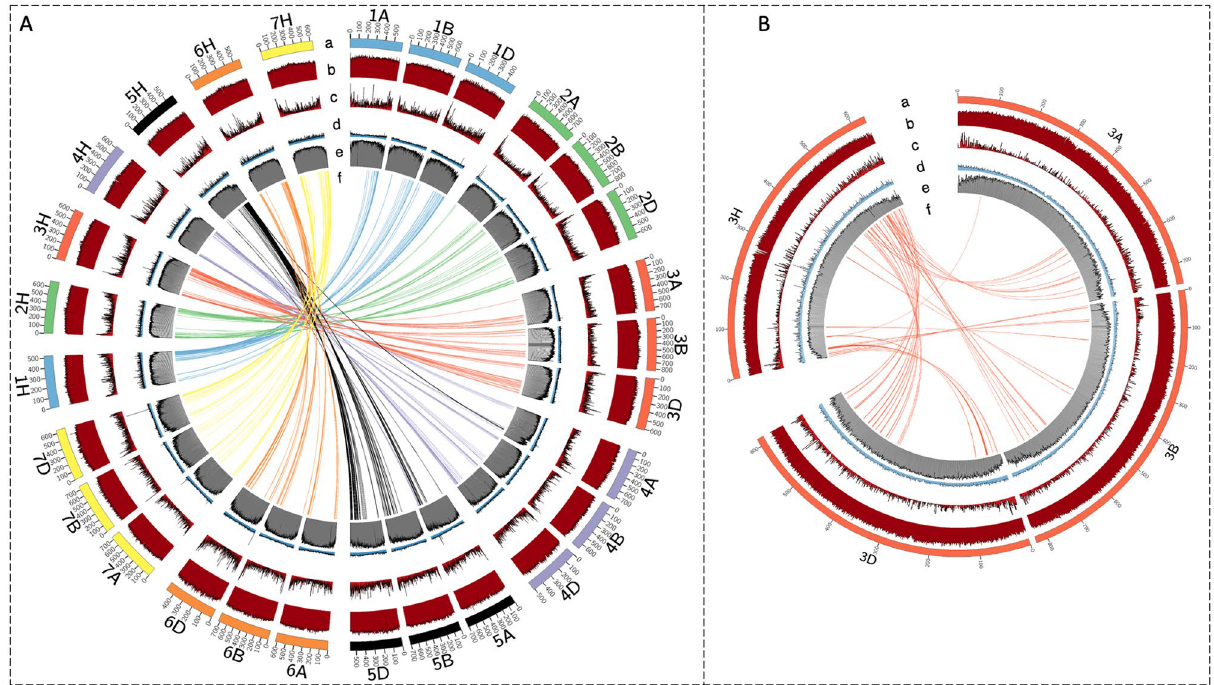
Figure 5. Circos diagram depicting the distribution of G4 motifs together with other regulatory elements in the barley and wheat genomes. Barley chromosomes are the H chromosomes and wheat chromosomes are the A, B, and D chromosomes. The plot shows the regulatory elements as from outside to inside: (a) ideogram the chromosomes (in Mb), (b) line graph of GC distribution as percentage to total number of bases, (c) histogram of high-confidence gene density, (d) line graph of G4 motif frequency, (e) histogram of transposable element density, and (f) syntenic genes between the barley and the wheat genomes. All chromosomes were shown ( A ) in the figure on the left and ( B ) a focused plot of chromosome 3 was shown on the